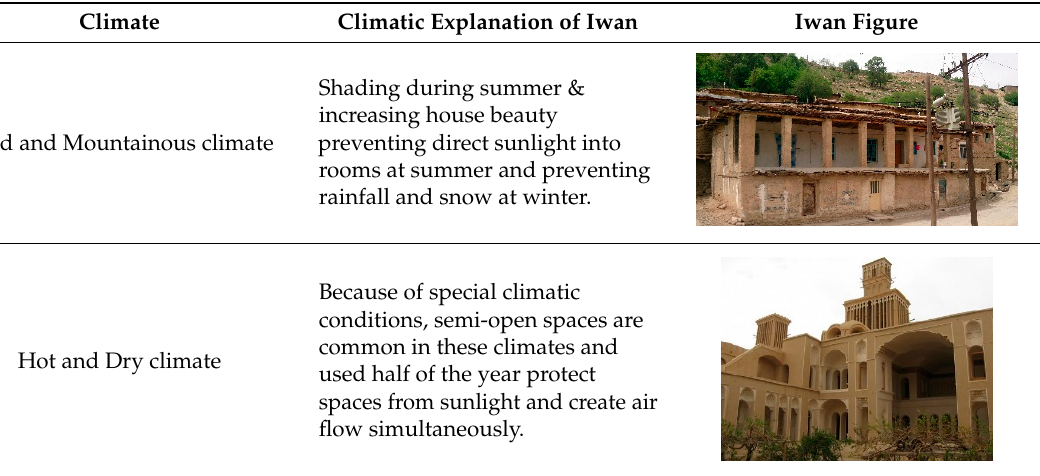
Table 1. Comparing Iwan application at different climates.